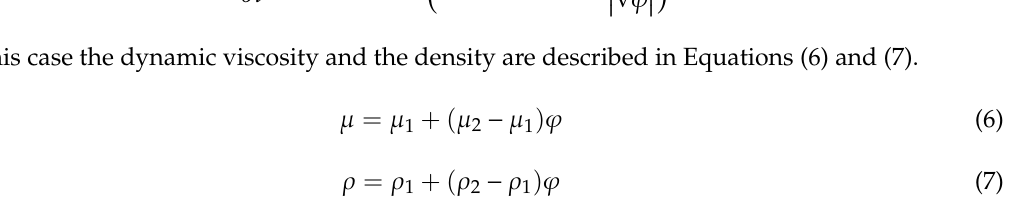
Figure 1. ( a ), ( b ) and ( c ) photos show droplet break up region for the three channels geometry which recorded from simulation as follows: ( a ) Traditional T-Junction; ( b ) double T-junction (DTJ) channel;